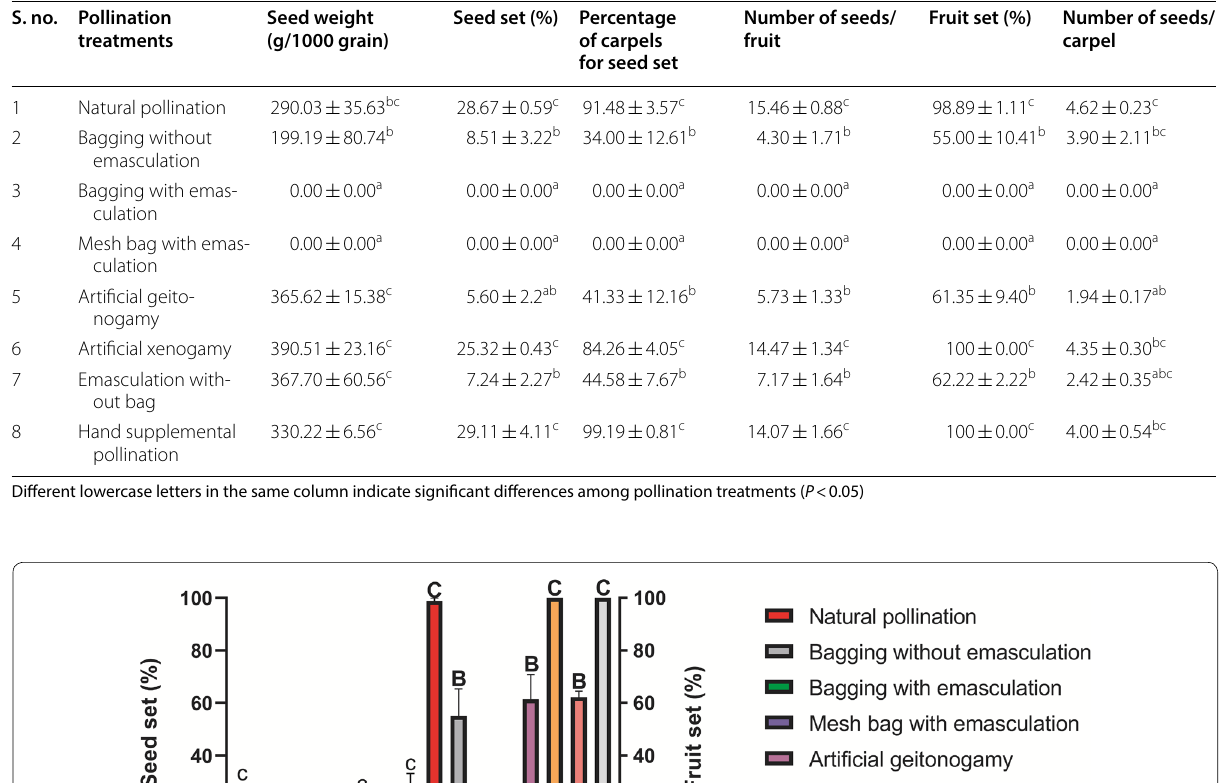
Table 2 Effects of different pollination treatments (mean